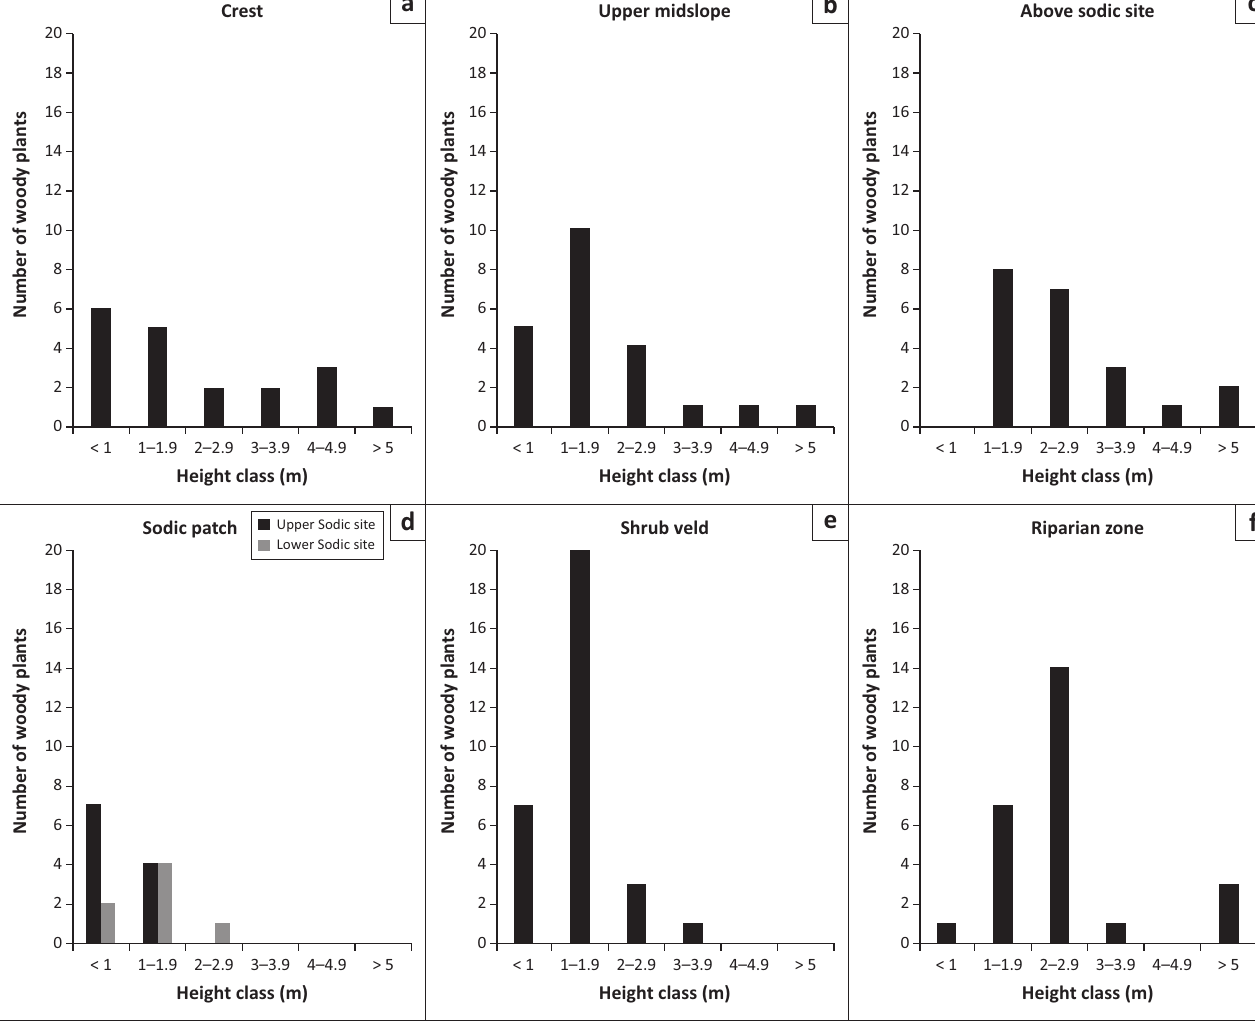
FIGURE 1: The number of woody plants (different species) in each height class for a transect that represents the following catenal zones: (a) crest, (b) upper midslope, (c) above sodic site, (d) sodic patch, (e) shrub veld and (f) riparian zone in the granite study area. The sodic patch was divided into an upper and a lower site, but both are indicated separately on the same